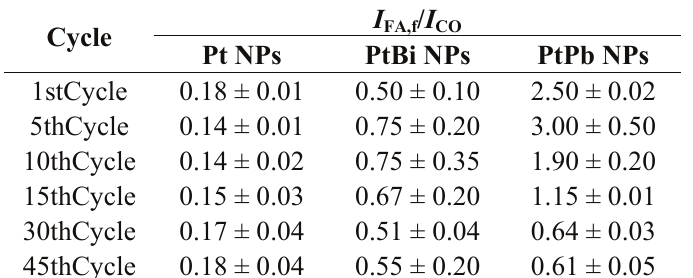
Table 1. The ratio of the current resulting from the oxidation of HCOOH to CO from the oxidation of CO to CO the three different electrodes coated with the mono- and bi-metallic nanoparticles.